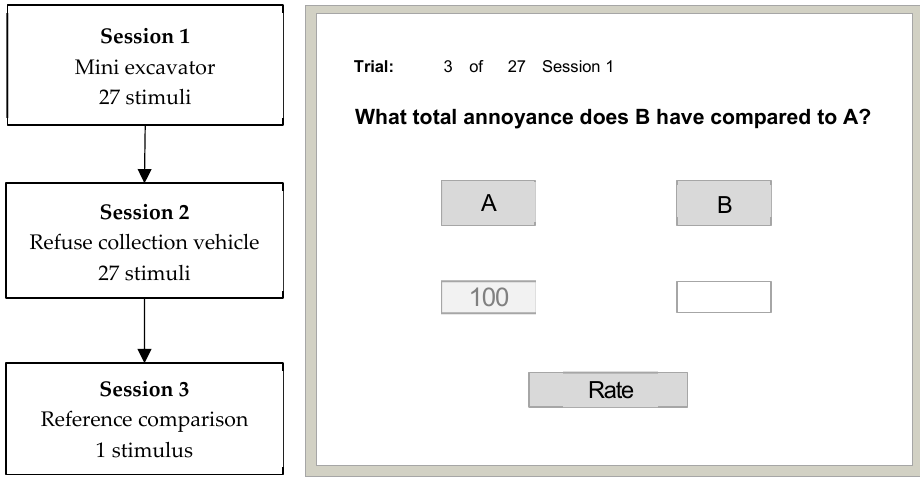
Figure 5. Figure on the right: Procedure of the experiment; figure on the left: GUI that the participants used to play back and rate the stimuli (the GUI have been translated to English for this figure).